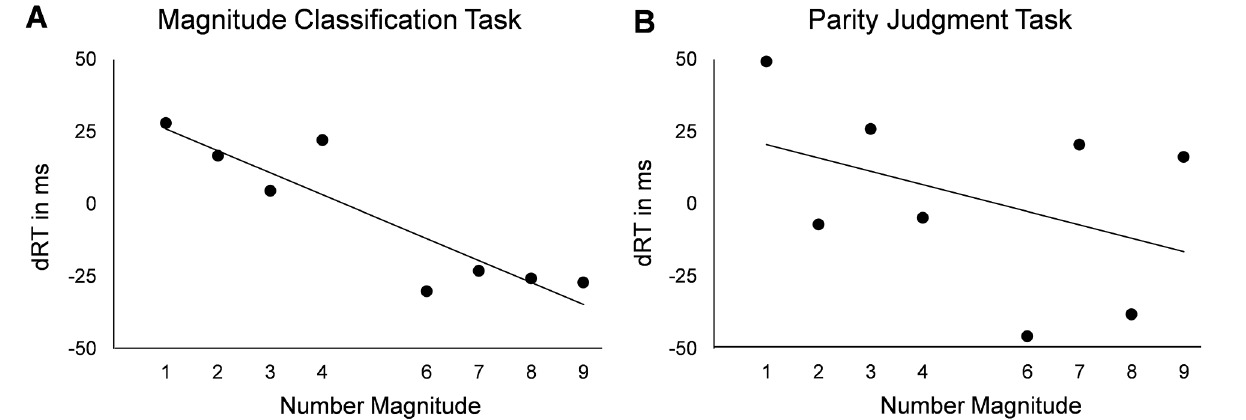
Figure 2. SNARC effects (i.e., interaction between response direction and number magnitude) for differences between RTs for movements to the right and movements to the left (dRT = right hand RT minus left hand RT) ( A ) in the magnitude classification task and ( B ) in the parity judgment task.